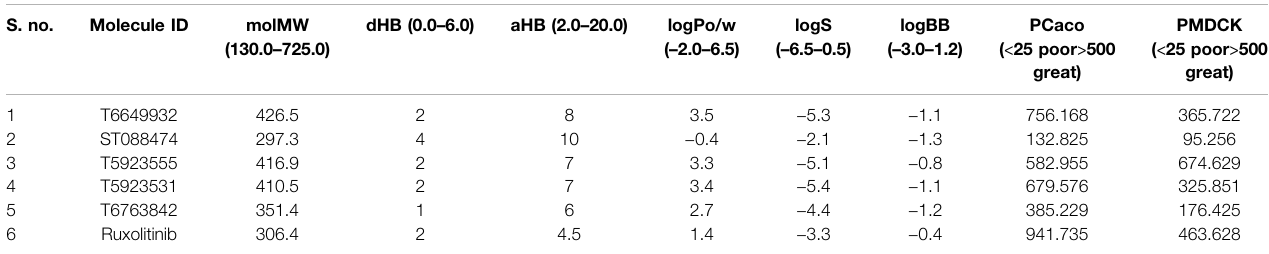
TABLE 6 | The drug likeliness properties of the selected lead compounds and the drug. S. no.